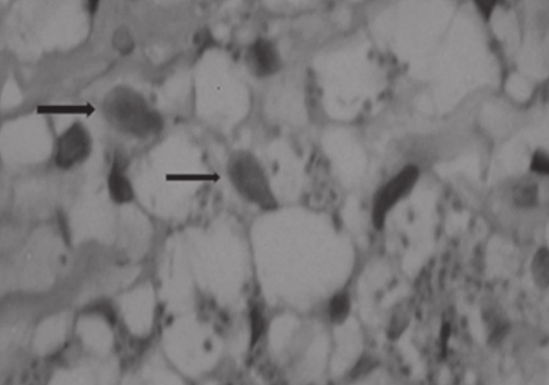
Figure 2: Yeast cells seen in the adrenal biopsy specimen